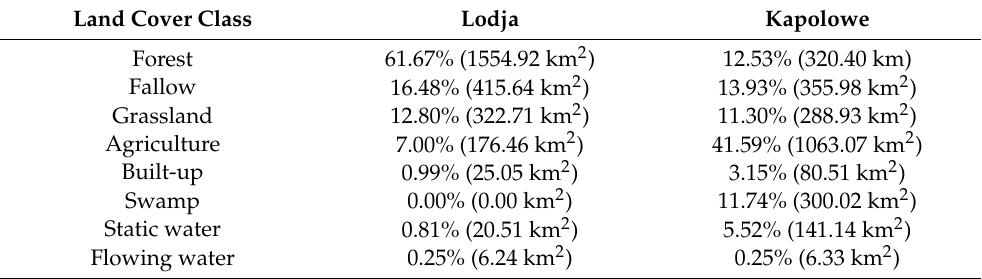
Table 4. Land cover class coverages for the Lodja and Kapolowe study areas.